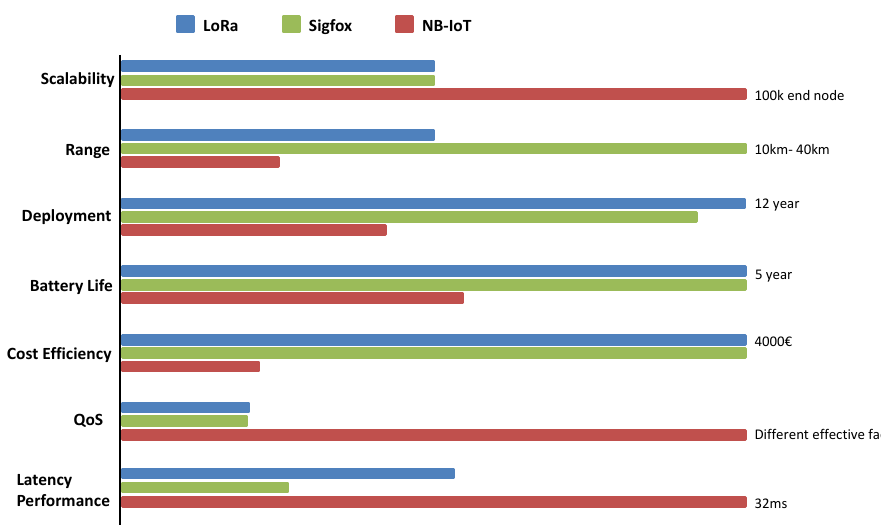
Figure 1. Performance comparison of LPWAN technologies. Adapted from